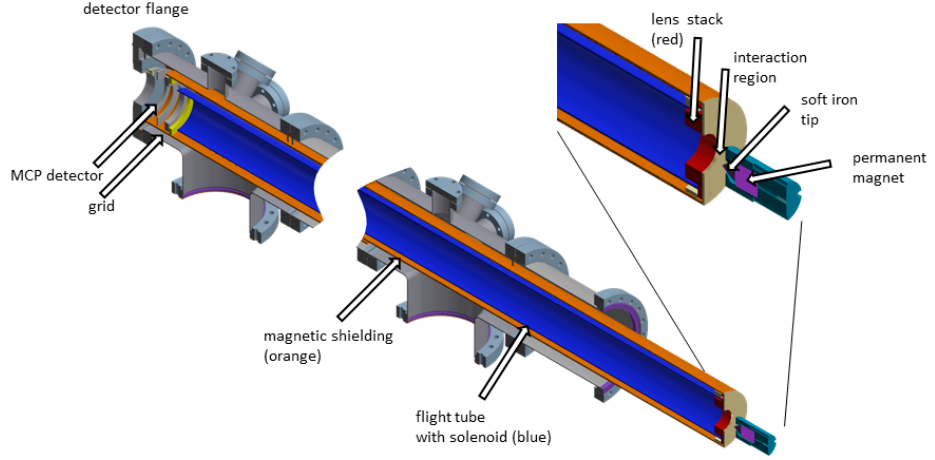
Figure 3. Cut-down scheme of the magnetic bottle time of flight spectrometer, with the magnified area around the interaction region. The interaction region is defined by the overlap of the optical and X-ray pulse with the region of highest sensitivity of the MBES. The magnetic field in the interaction region is dominated by the permanent magnet having a tapered soft-iron pole piece on top. The strong, inhomogeneous magnetic field drops quickly to a weak, homogeneous solenoid field surrounding the flight tube, thus guiding the electrons from the interaction region towards the detector. A µ-metal tube (orange) around the flight-tube and solenoid assembly (blue) shields the long flight region from external magnetic fields. At the entrance of the flight tube, an electrostatic lens stack can be used to retard the electrons to optimally utilize the energy resolution at a mean kinetic energy of choice. The micro-channel-plate (MCP) detector assembly contains a grid at the front to accelerate electrons towards the first plate. The grid and lens stack are equipotential so that the electrons travel through the flight tube with constant